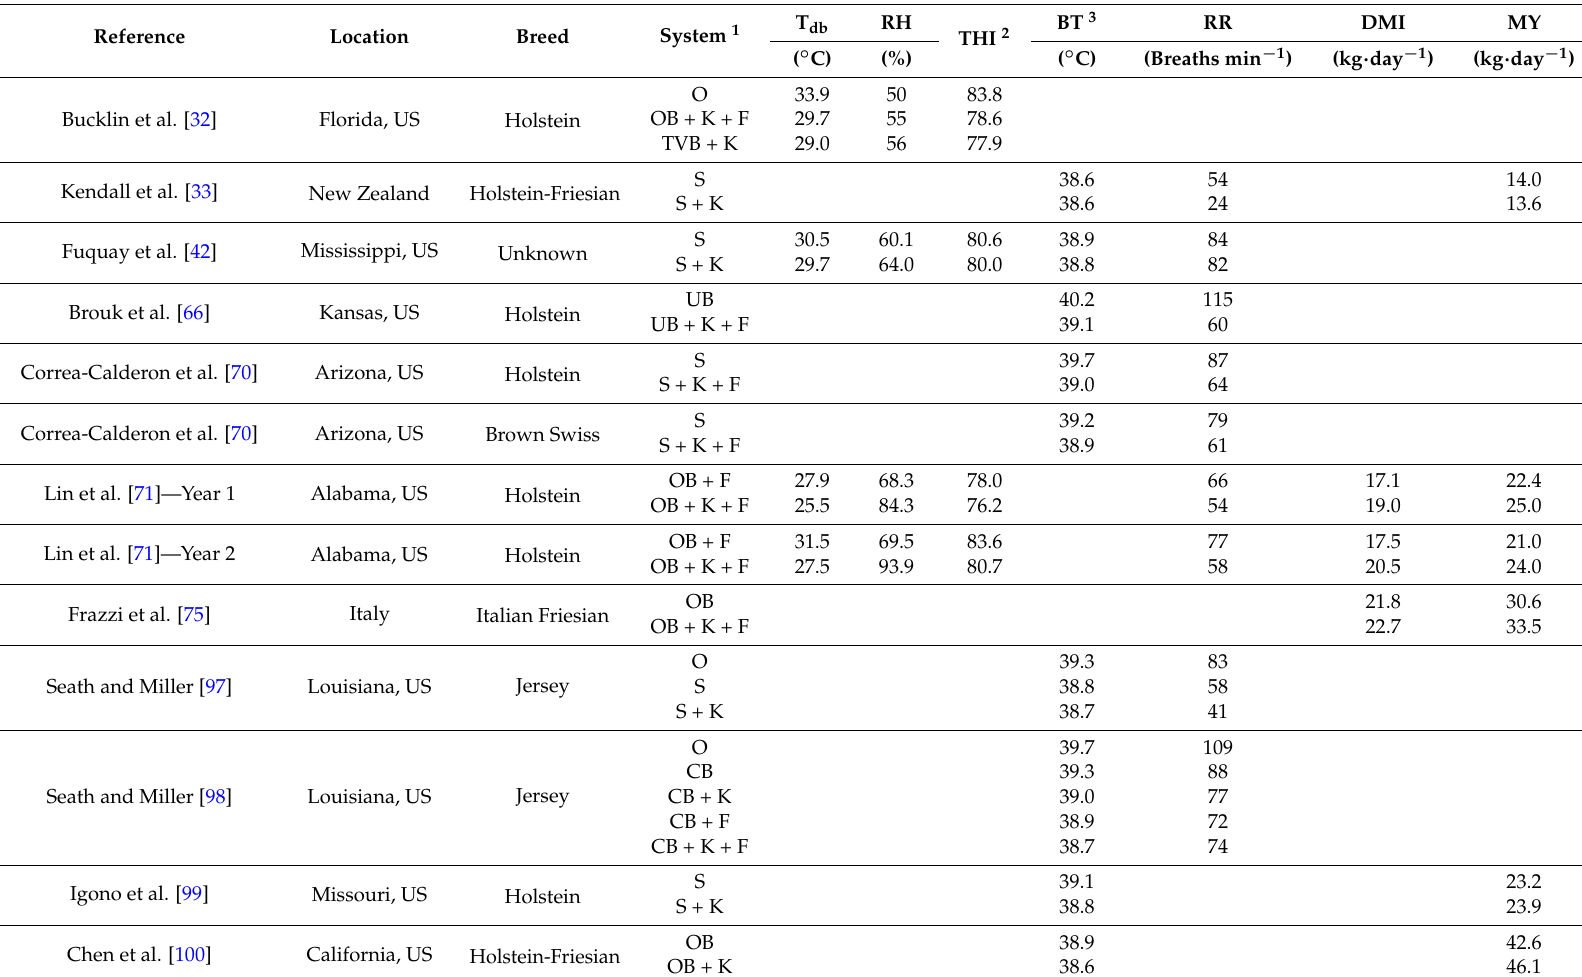
Table 10. Meteorological attributes, THI calculations, and physiological response of dairy cows for control treatments and barns equipped with